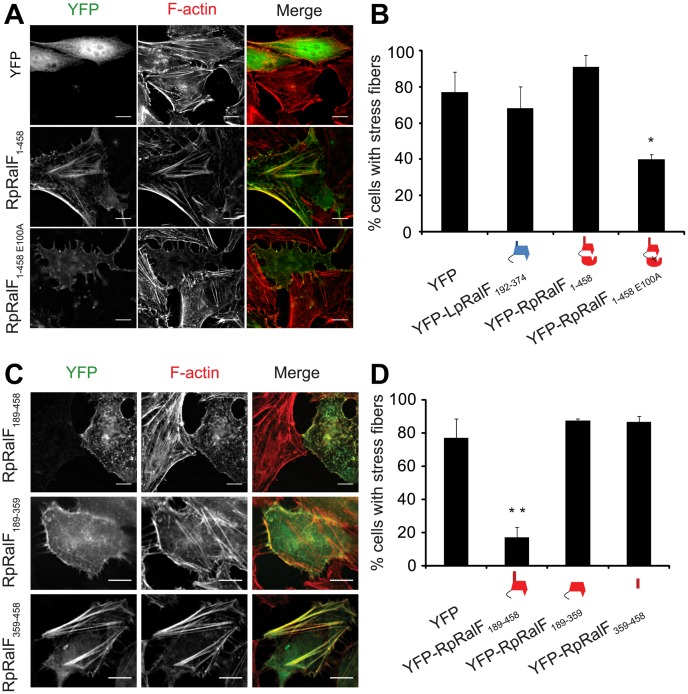
RpRalF modulates actin dynamics.
A) Hela cells transfected with plasmids encoding YFP, YFP-RpRalF1–458 or YFP-RpRalF1–458E100A were fixed 24 hours after transfection, then stained with Texas Red Phalloidin. Bar = 10 µm. B) Actin stress fibers disruption quantification. Cells were transfected with indicated YFP-tagged RpRalF or LpRalF constructs. 24 h after transfection, cells were fixed and actin was stained with phalloidin. The proportion of cells containing stress fibers was quantified for each construct. The standard deviation is derived from 3 independent experiments (* P<0.01, compared to YFP alone). C) and D) The RpRalF capping domain and a proline-rich region direct effector functions. C) Localization of ectopically expressed RpRalF189–458, RpRalF189–359 and RpRalF359–458. Hela cells were transfected with YFP-tagged RpRalF189–458, RpRalF189–359 or RpRalF359–458. 24 h after transfection, cells were fixed and stained with Texas Red phalloidin. Bar = 10 µm. D) RpRalF189–359 and RpRalF359–458 domains are both required for stress fibers disruption. Cells were transfected with indicated YFP-tagged RpRalF constructs. 24 h after transfection, cells were fixed and actin was stained with phalloidin. The proportion of cells containing stress fibers was quantified for each construct. The standard deviation is derived from 3 independent experiments (* * P<0.001).